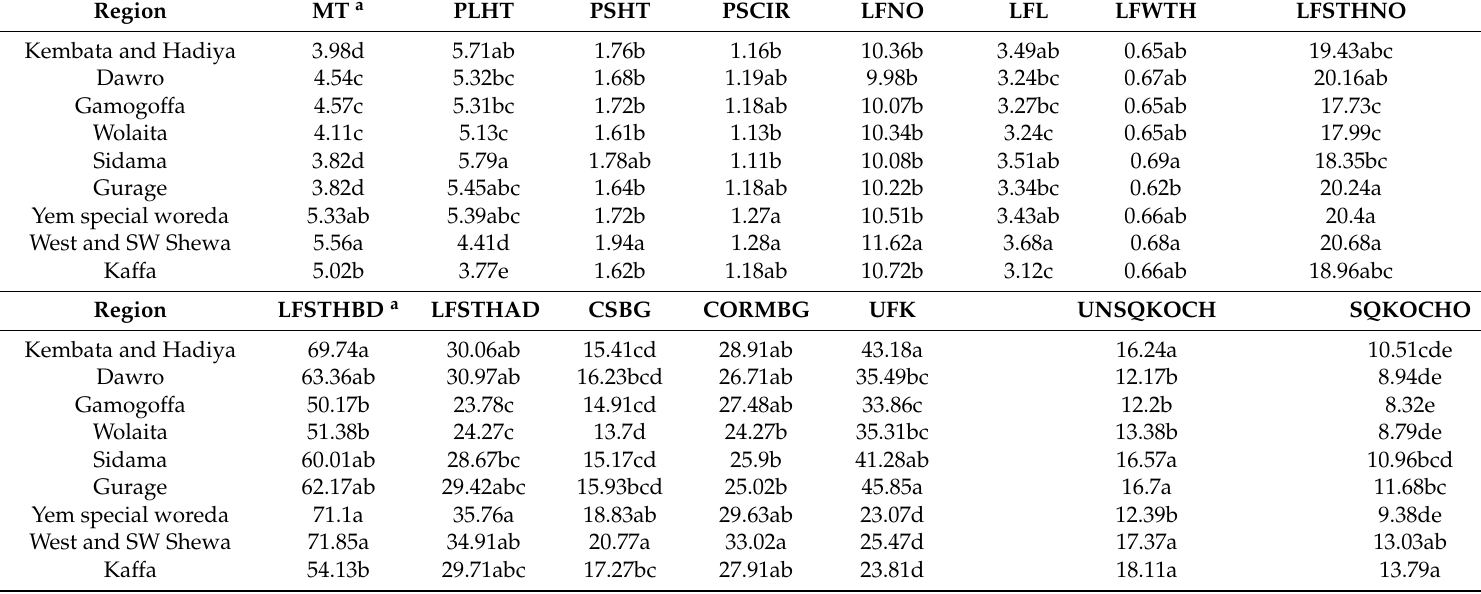
Table 3. Regional means for 15 characteristics in